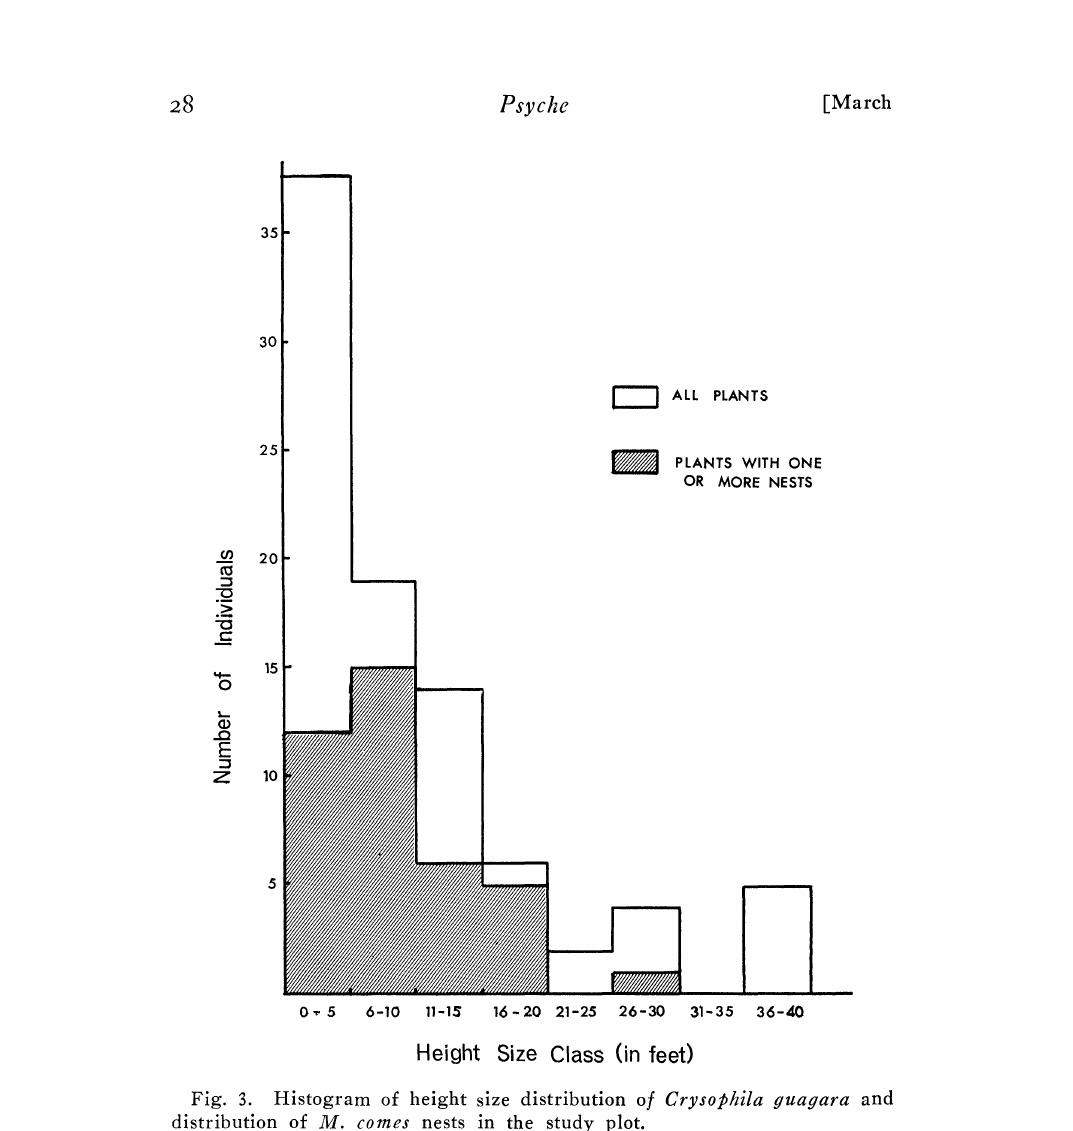
Fig. 3. Histogram of height size distribution of Crysophila tTuatlara and distribution of M. comes nests in the study plot. blunt-tipped setae at the end o the apical tergite (Fig. 6). Associ- ated with this setal brush is a rather large gland, the cells o which each have a well developed cuticular vesicular organelle and tubule (Fig. 7) similar to that described for the defensive gland o Eleodes longicollis by Eisner et al. (1964). Several tubules fuse and empty into the hollow bases of each of the brush setae. This